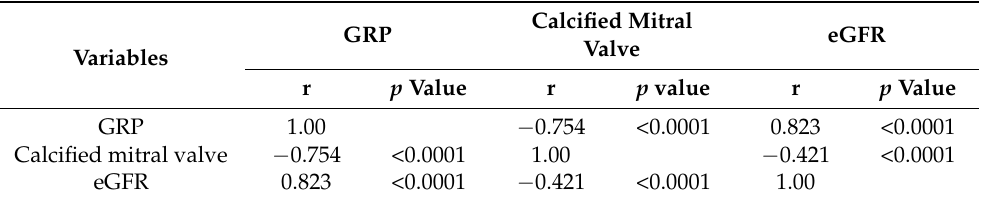
Table 3. Partial correlation analysis between GRP, calcified aortic valve and estimated glomerular filtration rate (eGFR) after adjustments for age and gender. GRP Gla-rich protein; eGFR, estimated glomerular filtration rate.